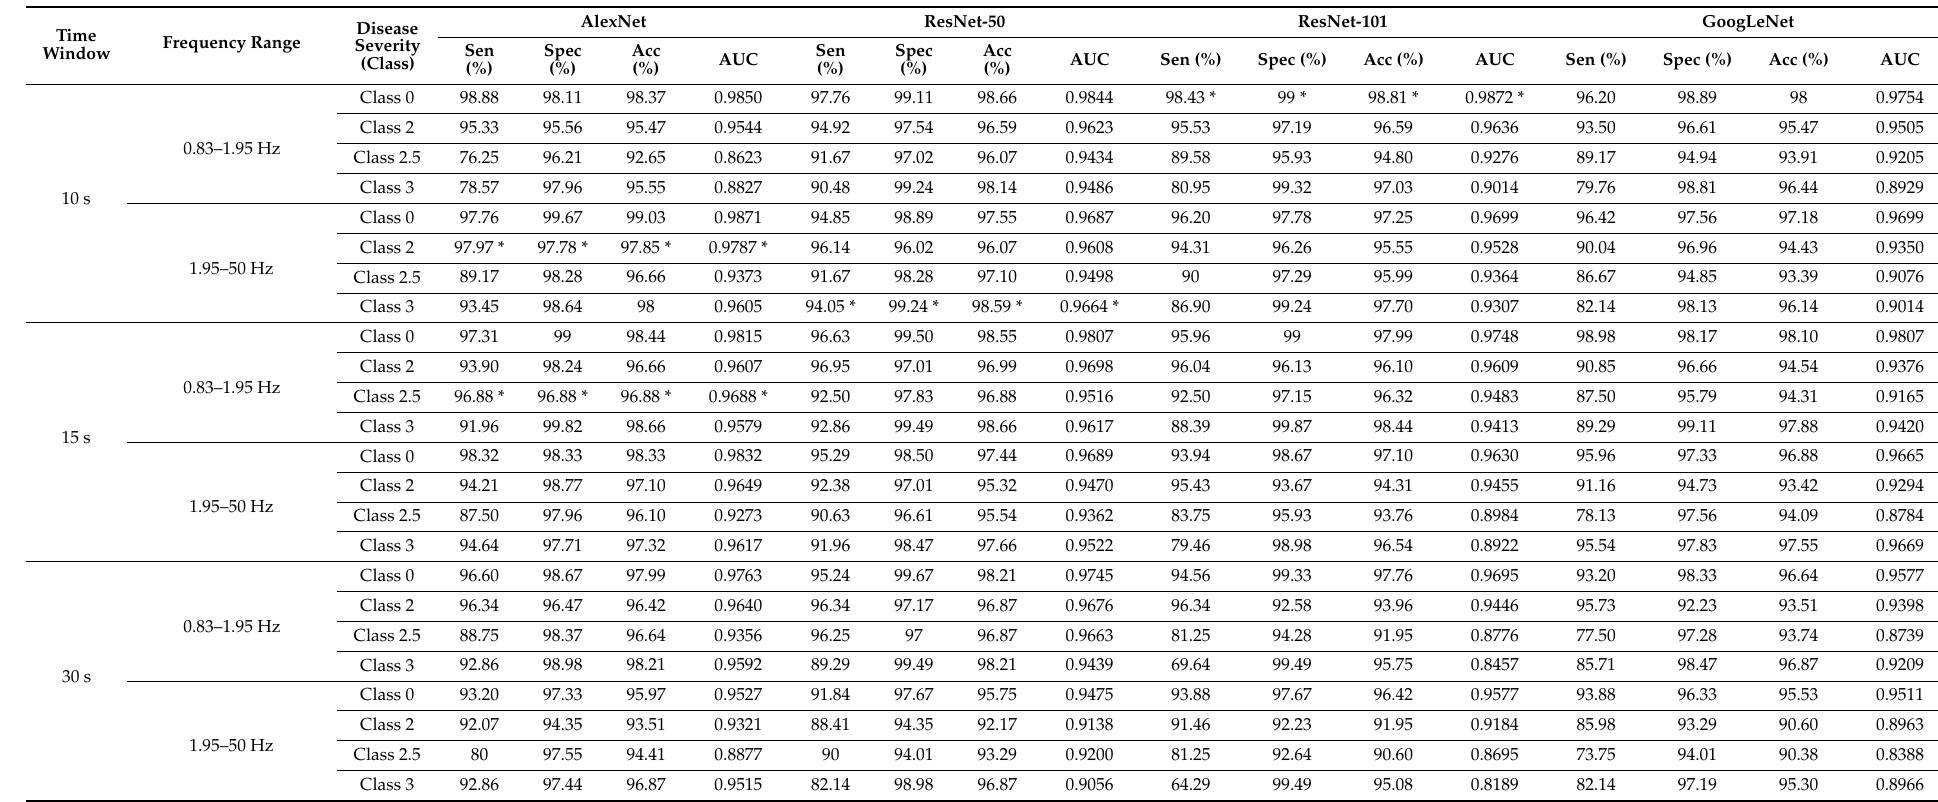
Table 8. Multi-class classification of RF from Ga dataset for CO (Class 0), PD Stage 2 (Class 2), PD Stage 2.5 (Class 2.5), and PD Stage 3 (Class 3) using several CNN classifiers (AlexNet, ResNet-50, ResNet-101, and GoogLeNet) with 10-fold